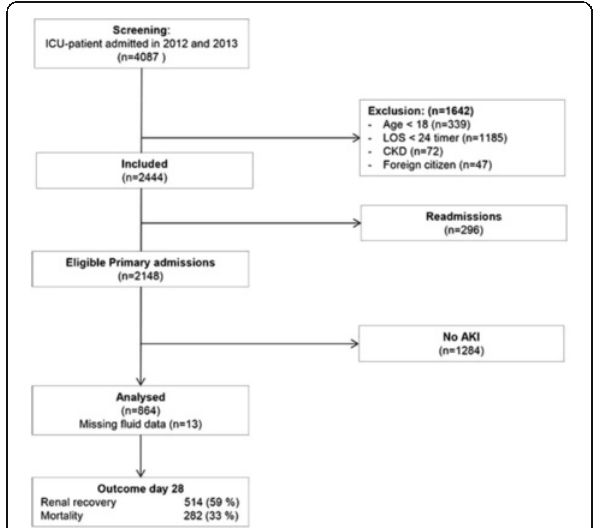
Fig. 37 (abstract A95). Study flowchart